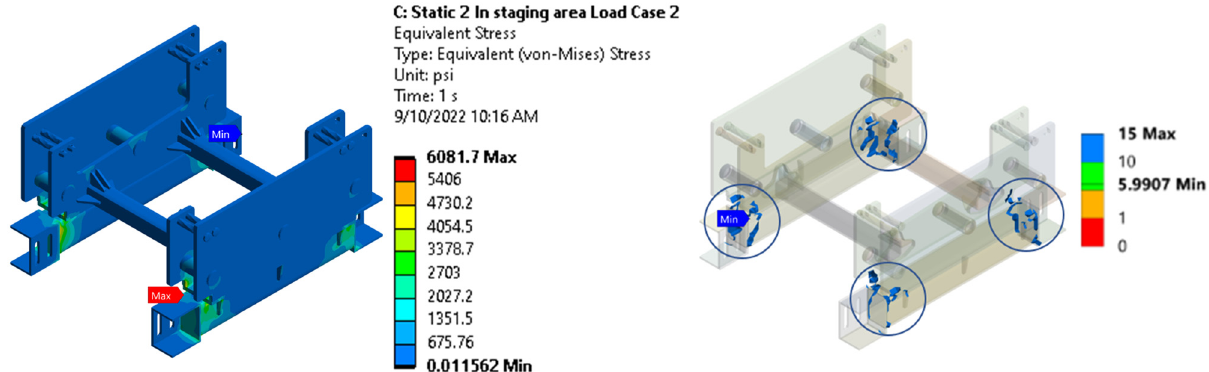
Figure 8: Equivalent ( von Mises ) stress and safety factor plot for load case 2 – Staging area